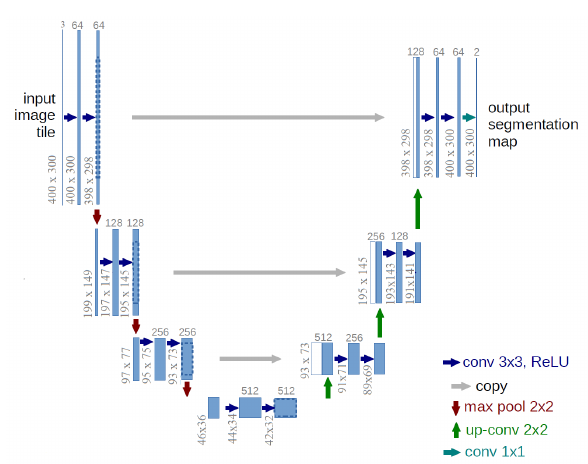
Figure 2. The U-Net based